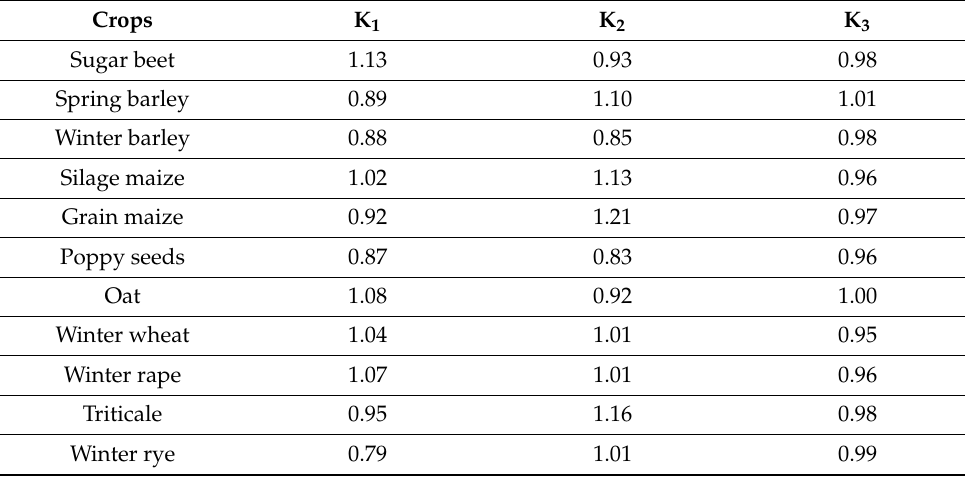
Table A13. Coefficients of mineral N, chemical treatment,